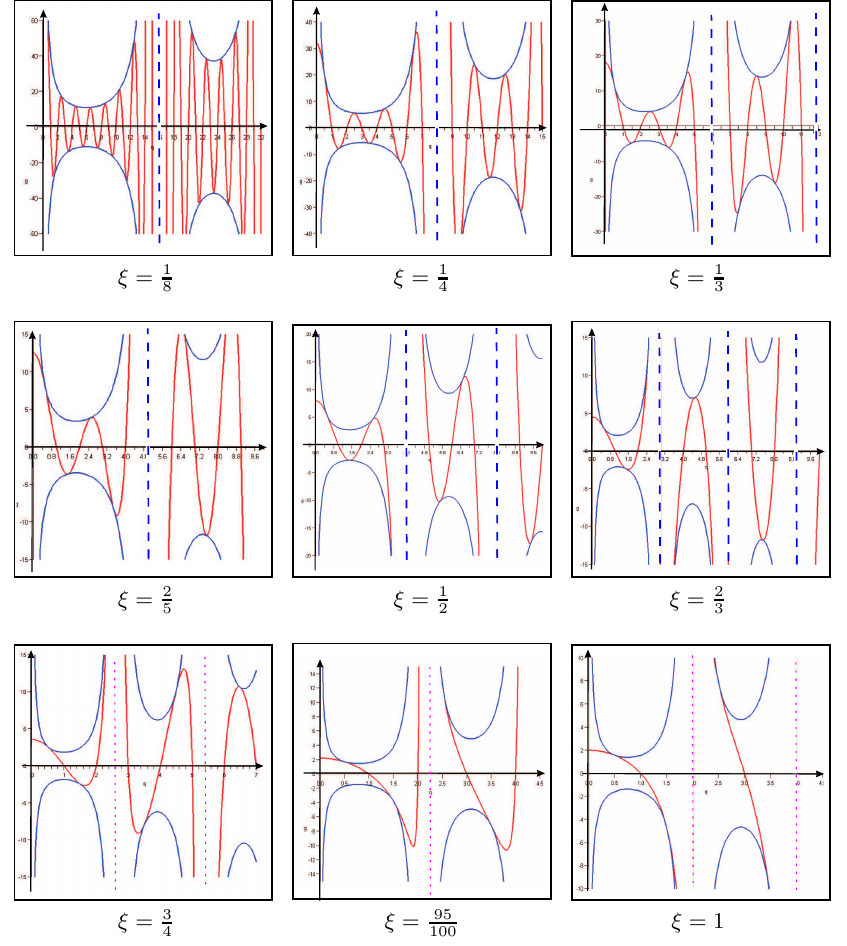
Figure 5. Functions (cid:13) + ( x=(cid:25) ; (cid:24) ) and (cid:6) g ( x=(cid:25) ; (cid:24) )